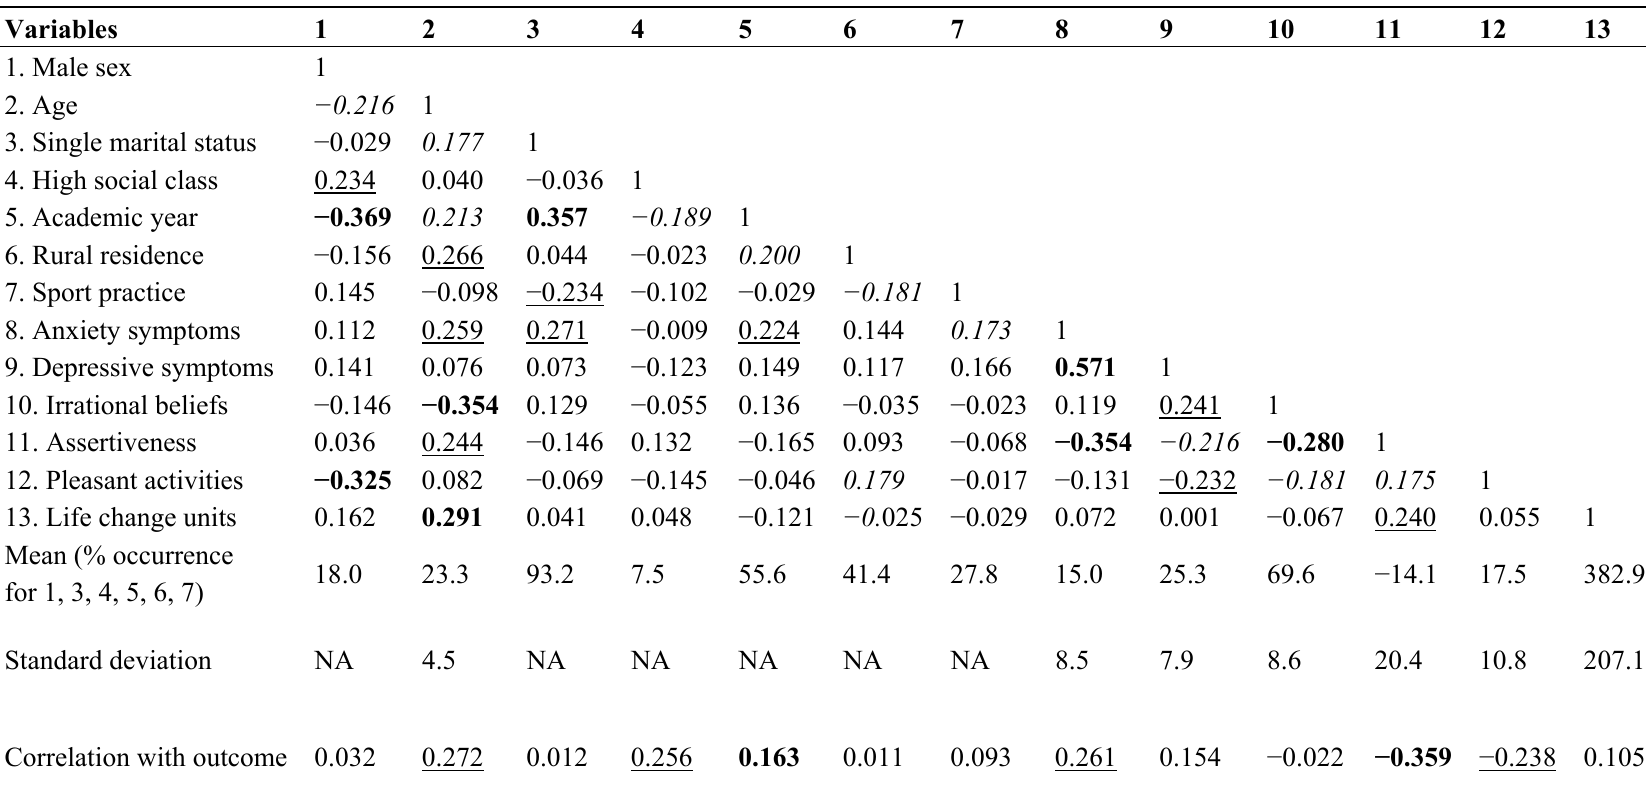
Table 1. Intercorrelation matrix of examined risk